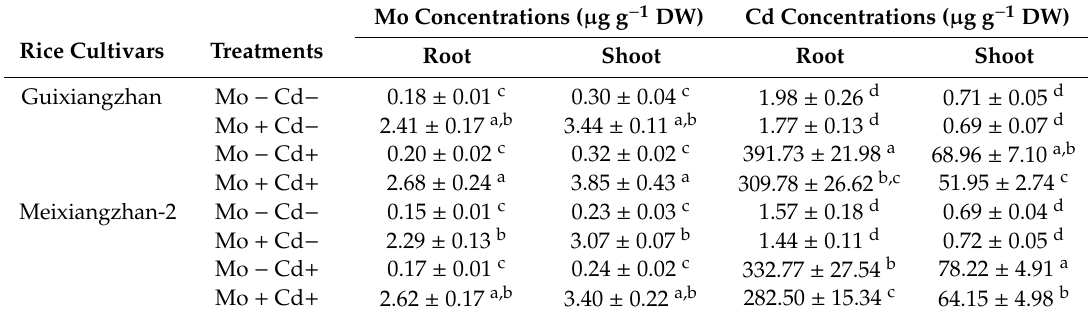
Table 3. Influence of molybdenum (Mo) supply on Mo and Cd concentrations in fragrant rice seedlings exposed to different cadmium (Cd) levels.